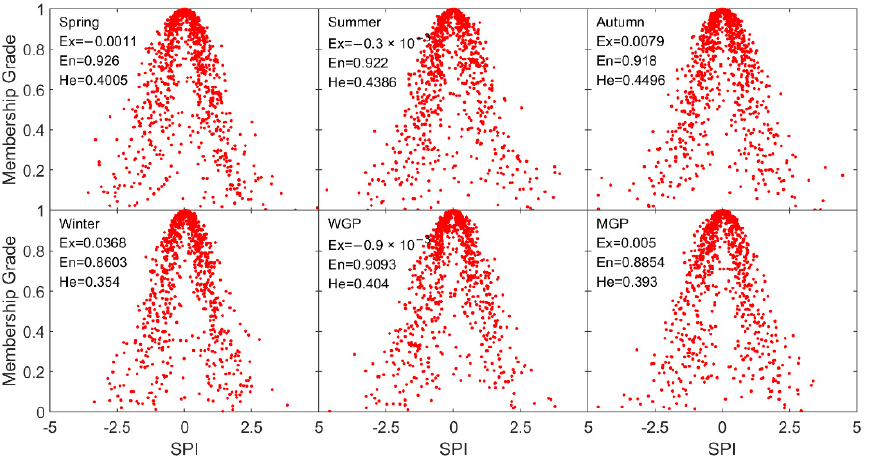
Figure 7. Cloud chart of the SPI membership degree at different timescales.